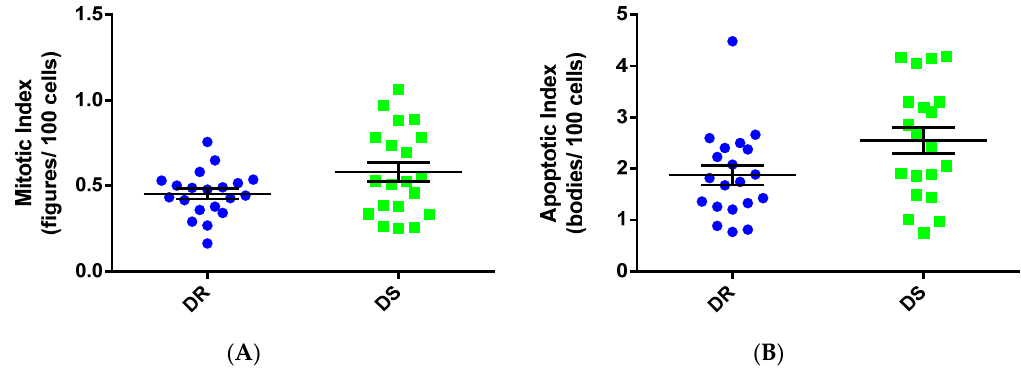
Figure 3. Mitotic and apoptotic indices in mammary carcinomas from dietary obesity sensitive (DS) and resistant (DR) rats. Bars indicate means ± SEM.